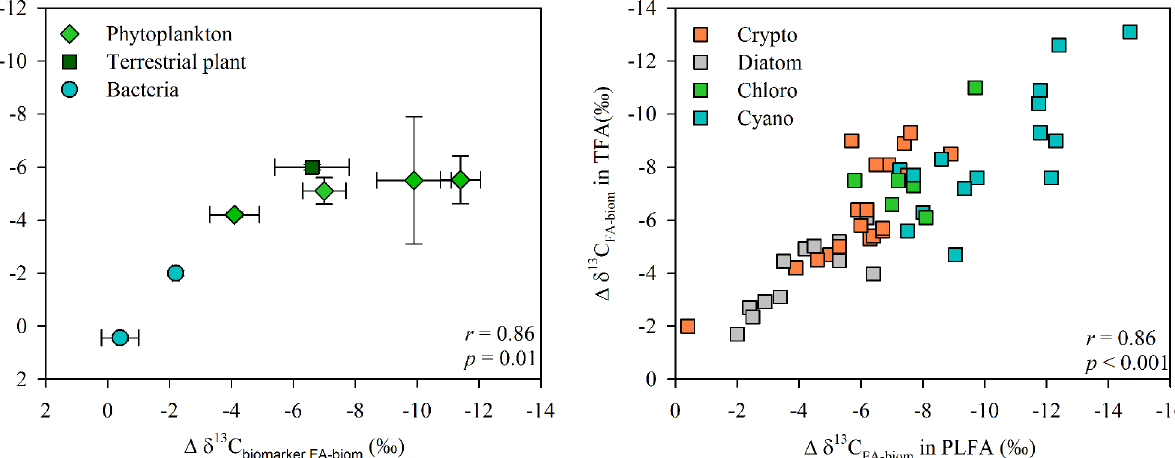
Fig 3. Isotopic difference between lipids or fatty acids and bulk biomass. a) The carbon isotopic difference ( Δ δ 13 C) between total lipids and bulk biomass is strongly correlated with the isotopic difference between biomarker fatty acids and bulk biomass for phytoplankton, bacteria and terrestrial organic matter. b) Carbon isotopic difference between total fatty acids and bulk biomass is strongly correlated with that between bulk biomass phospholipid fatty